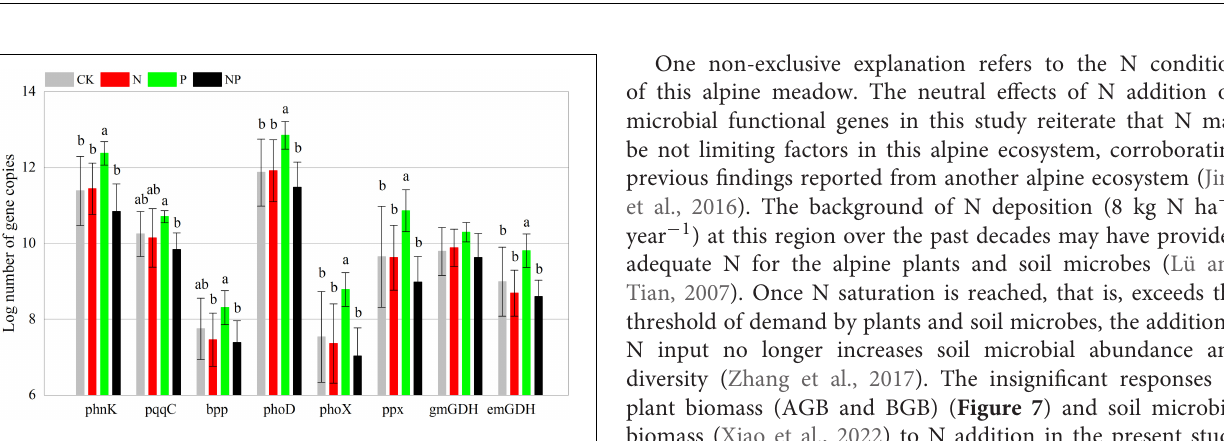
FIGURE 4 | Abundance of P cycling functional genes among experimental treatments. Different letters indicate significant differences at a p < 0.05 level across experimental treatments. No letter indicates a non-significant difference (CK = control, N = addition of 72 kg N hm − 2 year − 1 , P = addition of 36 kg P hm − 2 year − 1 , NP = interaction of N and